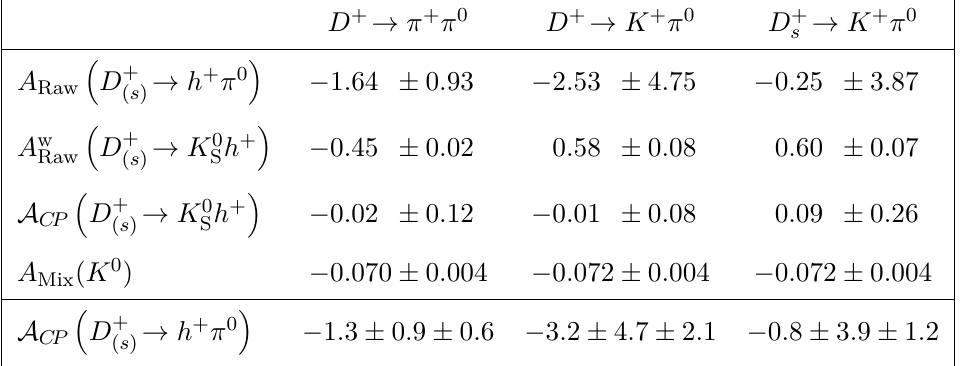
Table 5. Final A CP (%) results for the D + → h + π 0 modes. The uncertainties of A CP ( D + ( s ) h + π 0 ) are statistical and systematic respectively. The uncertainties of A Raw ( D + purely statistical. The uncertainties of A Mix ( K 0 ) are systematic. Externally measured values of A CP ( D + → K 0 h + ) are taken from refs. [18, 37–41]. For comparison the unweighted control S ( s ) asymmetries are A Raw ( D + → K 0 π + ) = − 0 . 45 ± 0 . 02 , A Raw ( D + → K 0 S A Raw ( D + → K 0 K + ) = 0 . 51 ± 0 . 04 s S